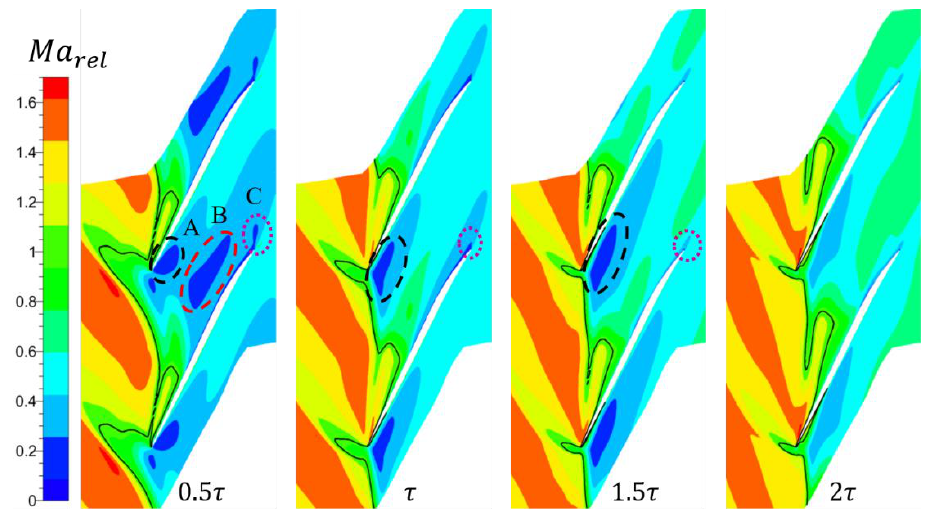
Figure 19. Relative Mach number contours on the rotor blade tip plane at the near stall point.